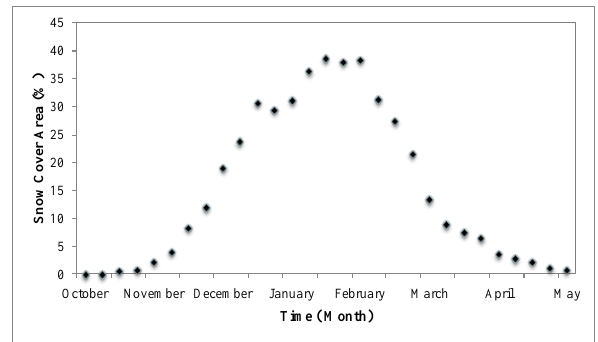
Figure 2. Variation of annual average for each 8- day